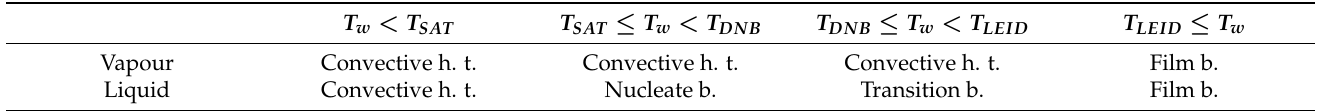
Table 4. Heat transfer regimes partitioning. T w < T SAT Vapour Convective h. t. Convective h. t. Convective h. t. Film b. Liquid Convective h. t. Nucleate b. Transition b. Film